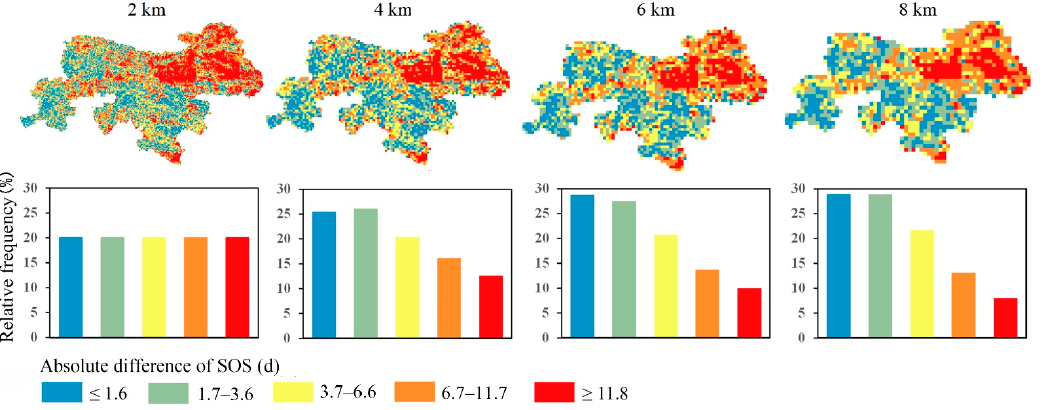
Figure 10. Absolute differences between the up-scaled results from the 250 m and 1000 m SOSs retrieved by AG-filtering. Days 1.6, 3.6, 6.6, and 11.7 correspond to the 20%, 40%, 60%, and 80% cumulative frequency of the 2 km SOS difference, respectively.